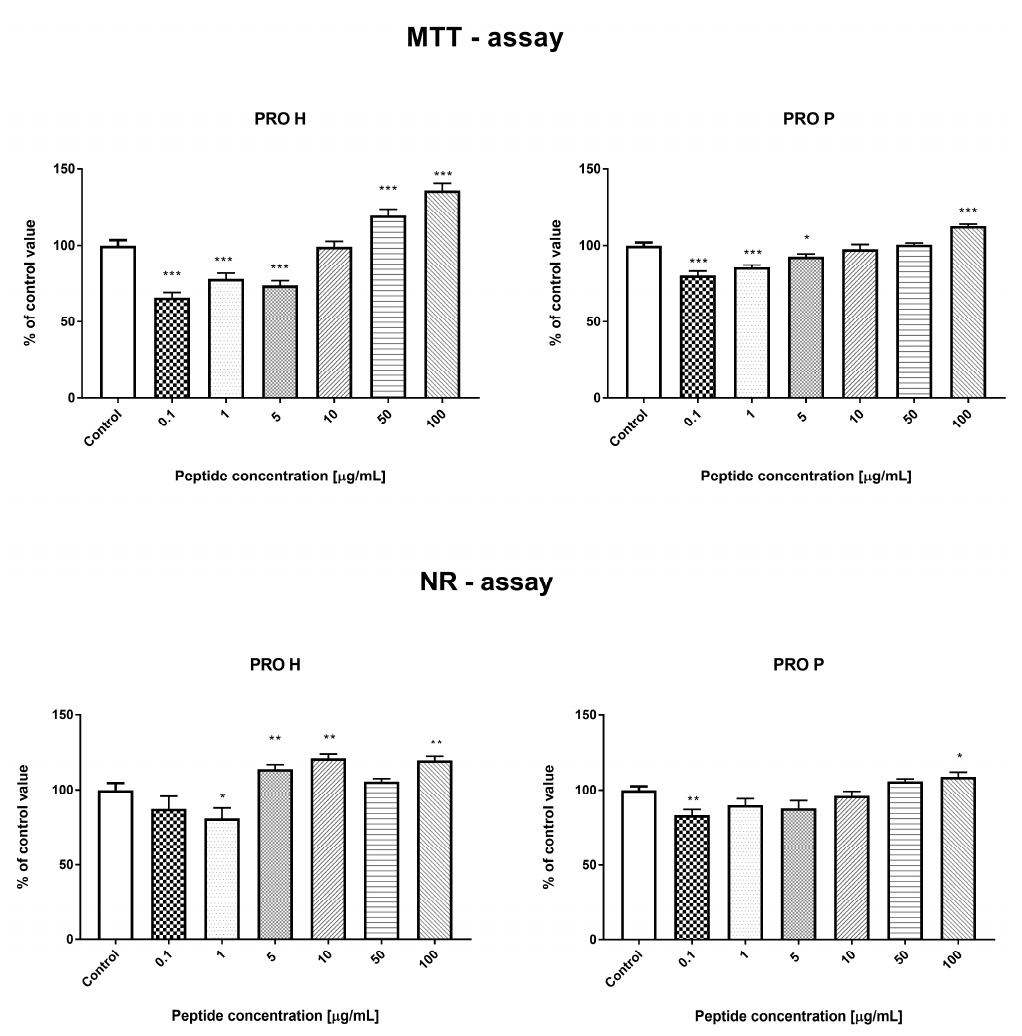
Figure 1. Result of MTT and neutral red (NR) tests for prolamin hydrolyzate (PRO H) and peptide fraction (PRO P). * p < 0.05; ** p < 0.01; *** p < 0.001